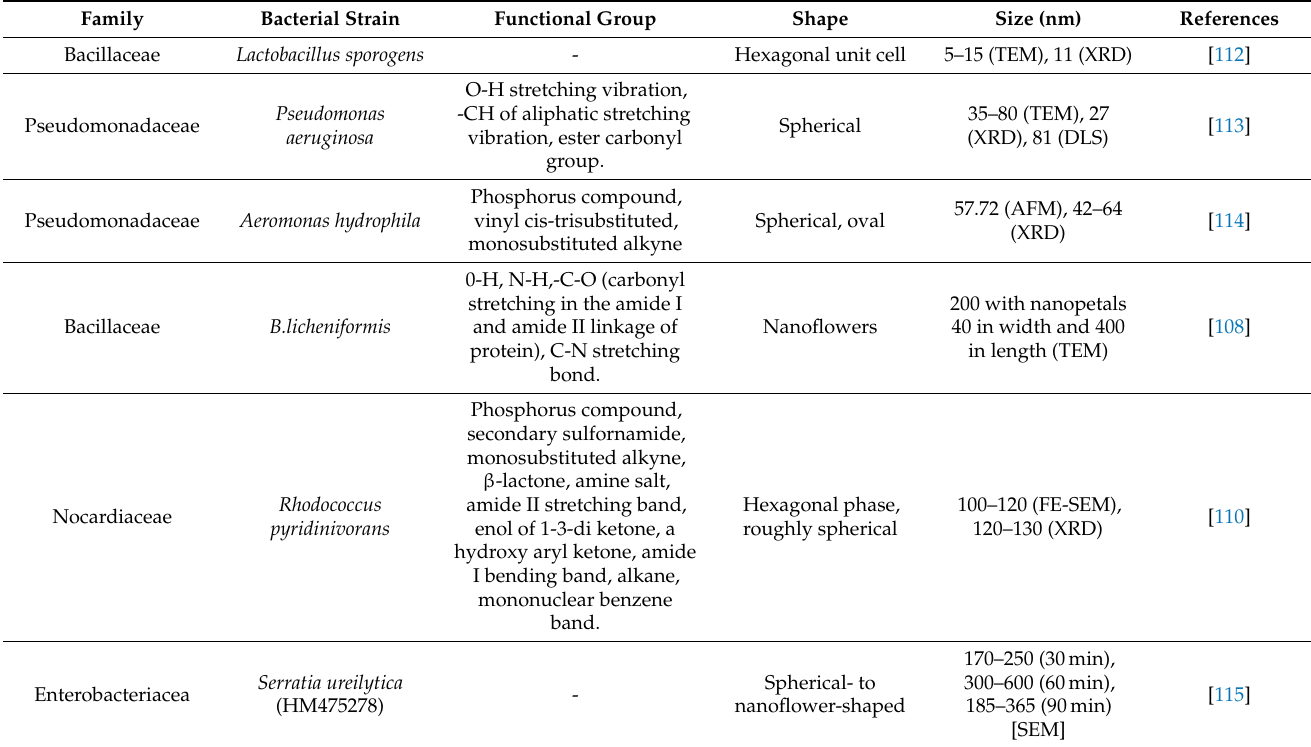
Table 2. Synthesis of ZnO-NP using bacterial strain.